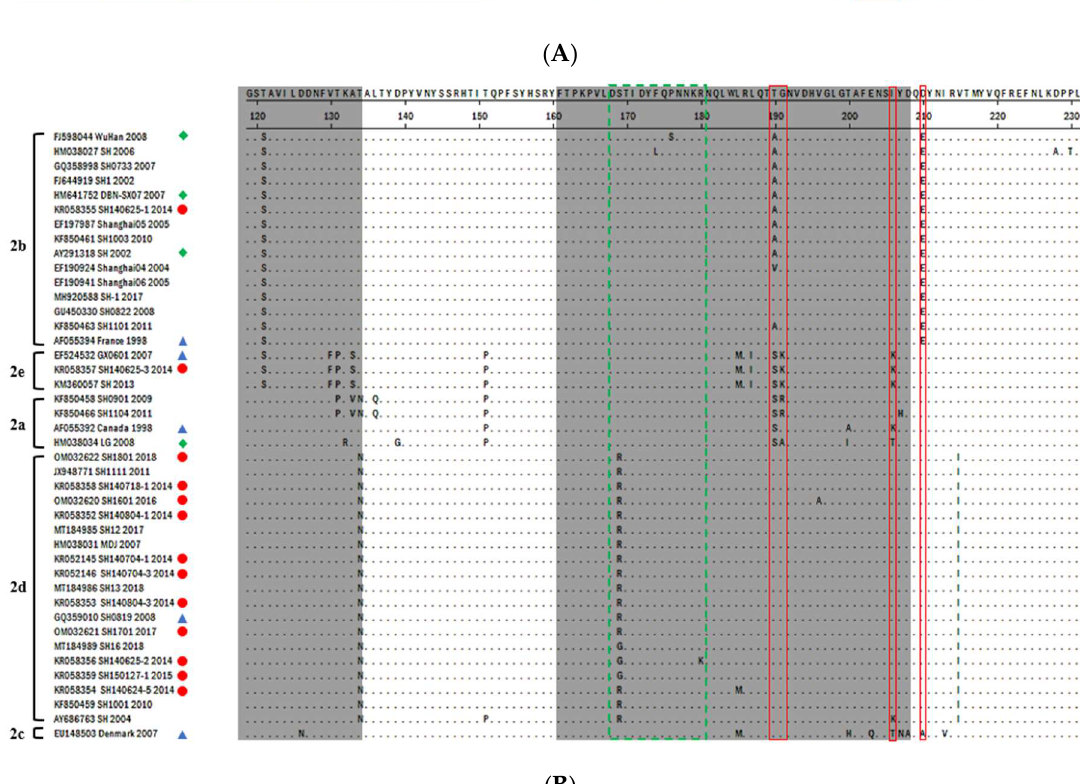
Figure 1. Alignment of capsid protein sequences of thirteen PCV2 isolates: ( A , B ) ; The grey highlighted area represents antibody recognition domains as described by Trible et al. (2011) [45]. The red solid line boxes show motifs of PCV2 determined by Cheung et al. (2007) and Cheung et al. (2009) [5,43]. The dashed green line represents the location of the immunodominant decoy epitope, which shows reactivity of PCV2 infected pigs’ serum rather than vaccinated pigs’ serum as reported by Trible et al. (2011) and Trible and Rowland et al. (2012) [45,48]. The new PCV2 isolates identified in this study are labeled with red circles and PCV2 available vaccine strains are indicated with green triangles.